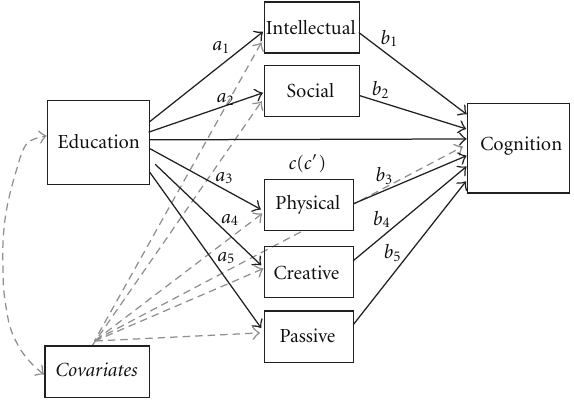
Figure 1: Example of multiple mediator